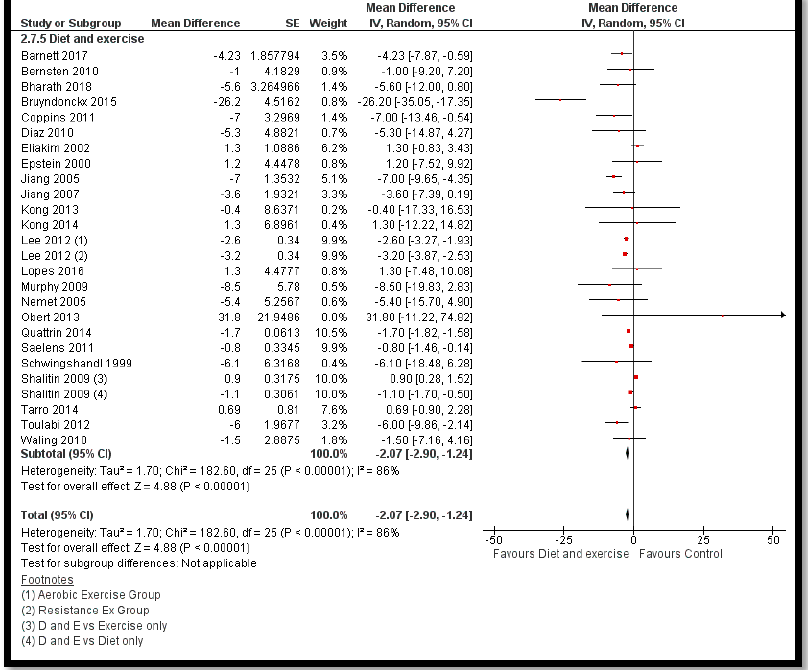
Figure 15. Forest plot for the e ff ect of diet and exercise interventions for obesity management on body weight .